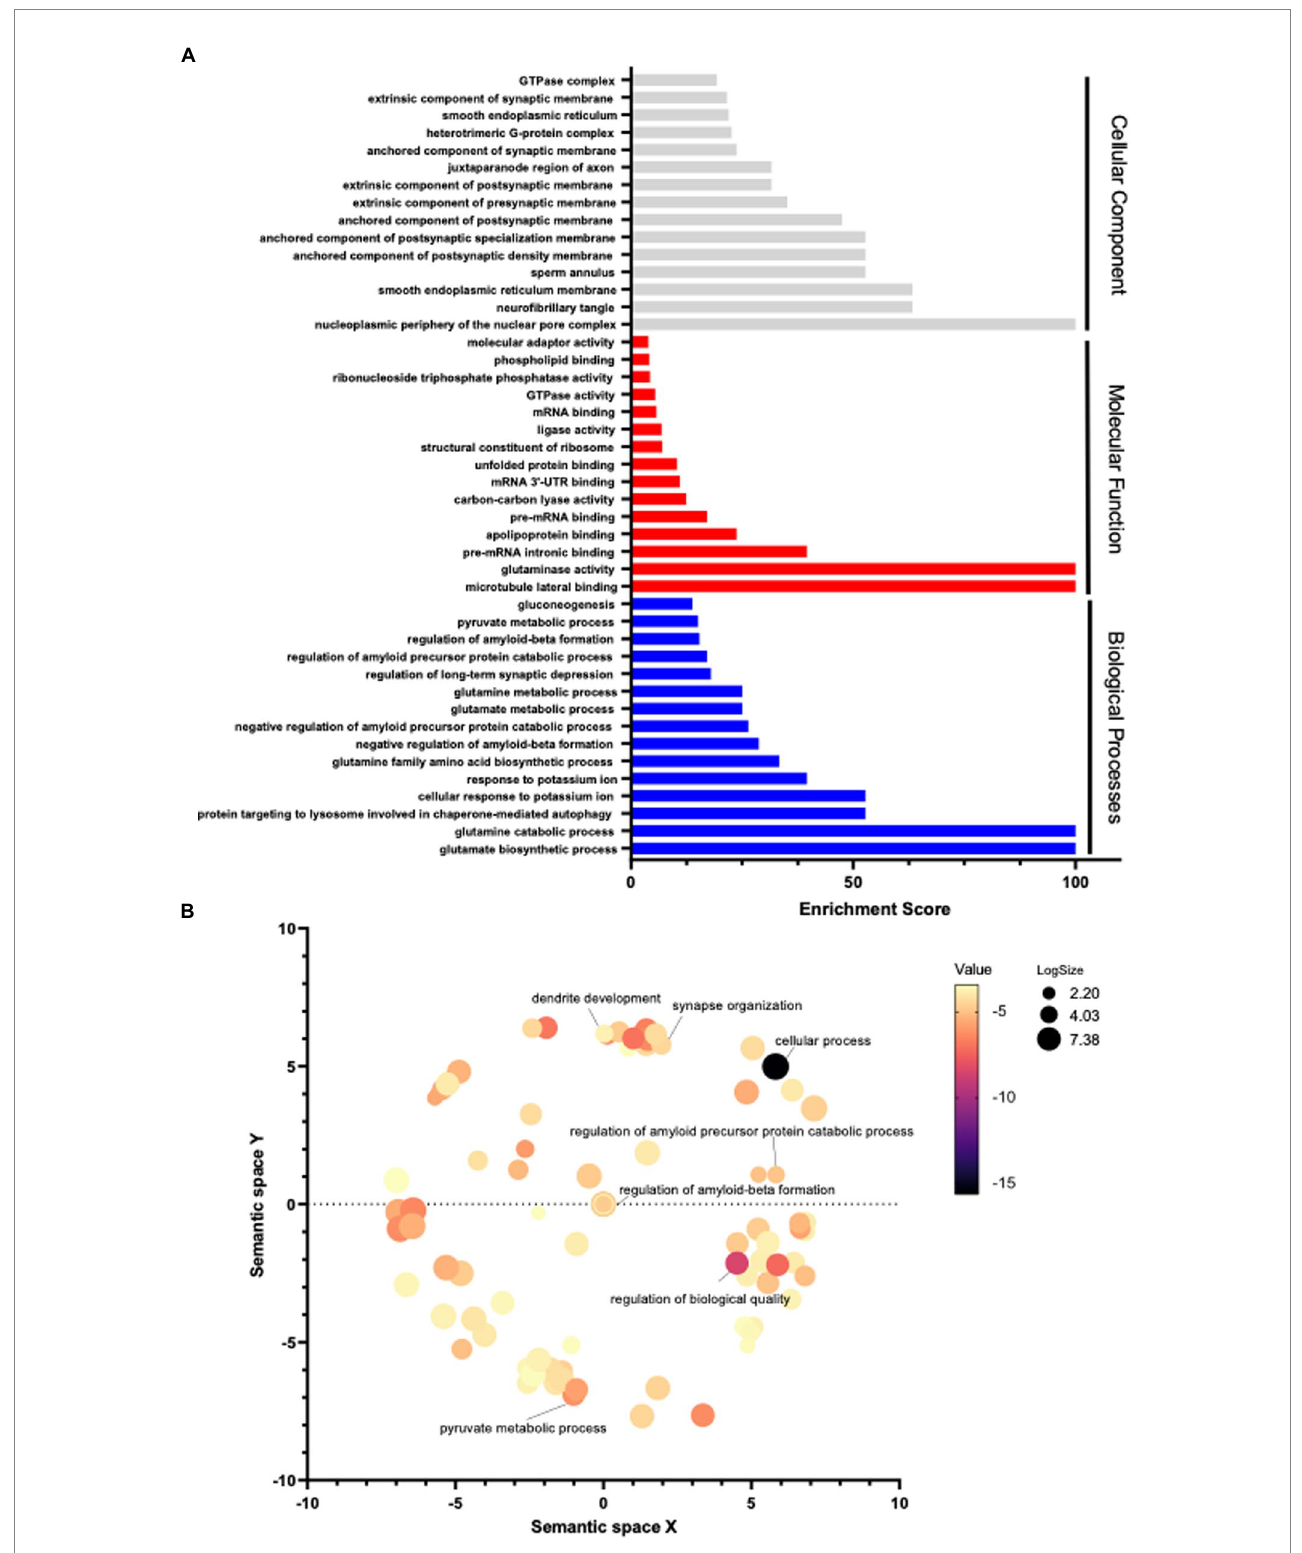
FIGURE 9 Pathway analysis in the brain of APP/PS1 mice. (A) Using the significantly differentiated proteins identified via proteomic analysis, a Gene Ontology pathway analysis was performed. Pathways with an FDR <0.05 were included, the top 15 significant pathways per category are graphed by enrichment scoring. (B) GO pathway analysis of biological processes was visualized by functional grouping. 3 mice per